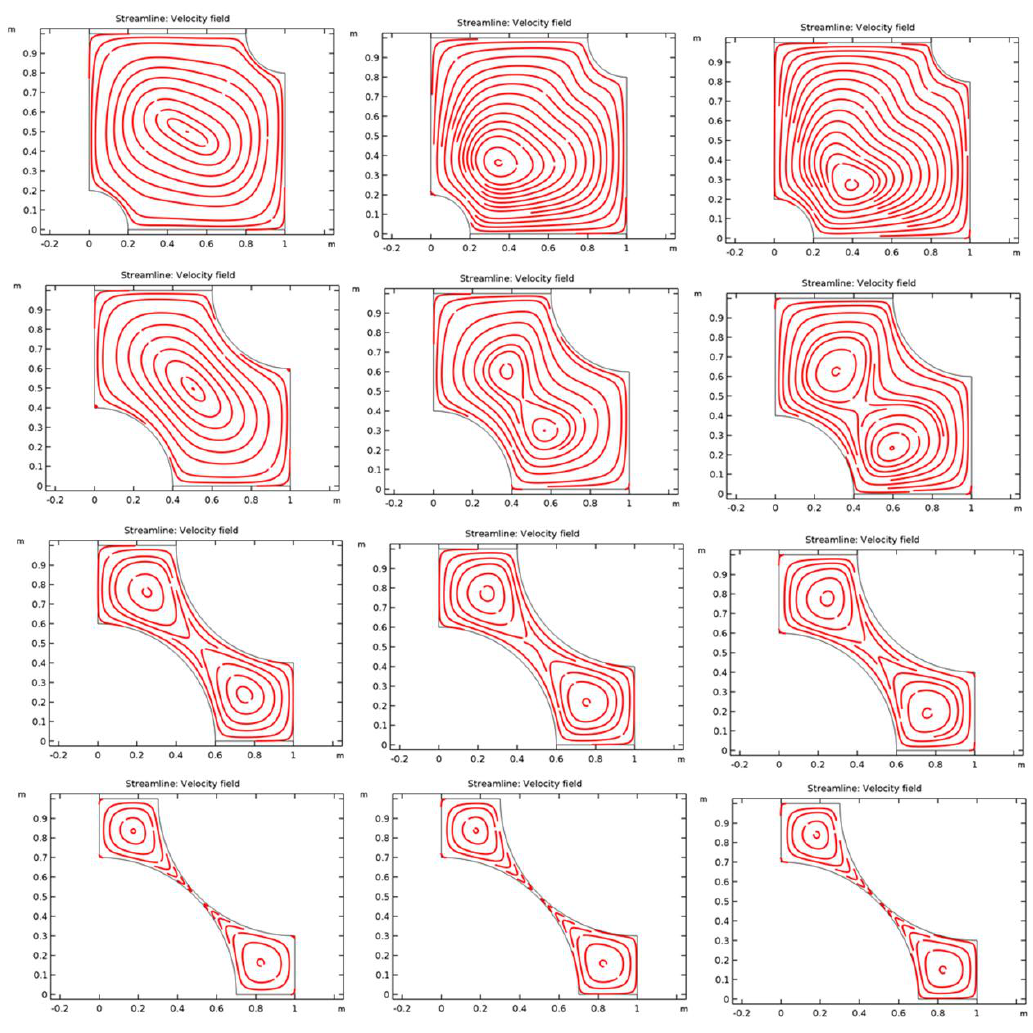
Figure 9. Effect of Hartmann number and Rayleigh number on the surface velocity streamlines. Results show that the flow streamlines present globally an elliptical core vortex oriented towards the diagonal direction of the cavity. Two elliptical core vortexes were encountered for higher round corner radius and higher Hartmann number, inducing two almost separated cavities. The minimum velocity magnitude of the flow was reached in the central zone and near the walls of each nanofluid filled cavity, while its maximum value was reached all around the central zone. This maximum value was decreased as the round corner radius increased from R = 0.2 to R = 0.7. Results show, also, that, as the Hartman increased from Ha = 0 to Ha = 40, the zone of maximum velocity magnitude will be pushed away from the magnetic source, towards the down left side of each nanofluid filled cavity, while the maximum value of the velocity magnitude was decreased. It is to note, also, that the increase in Hartman number favors the establishment of a second zone of minimum velocity